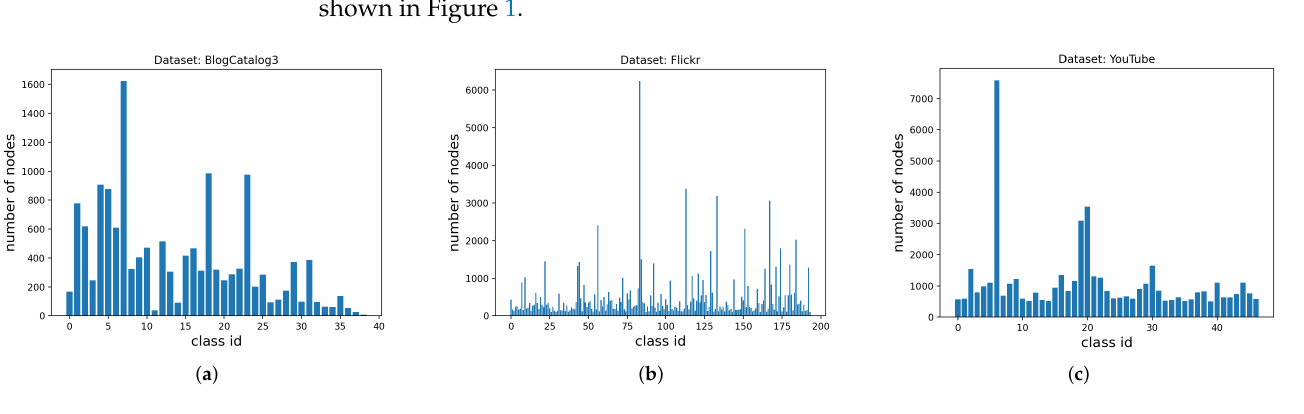
Figure 1. Label distribution of three real-world multi-label network datasets: ( a ) BlogCatalog3 [6], ( b ) Flickr [6], and ( c ) YouTube [7]. The horizontal axis represents the label id, and the vertical axis represents the number of nodes containing each label. It can be clearly observed that these label distributions are all highly imbalanced, where a few classes contain many more nodes than the rest of the